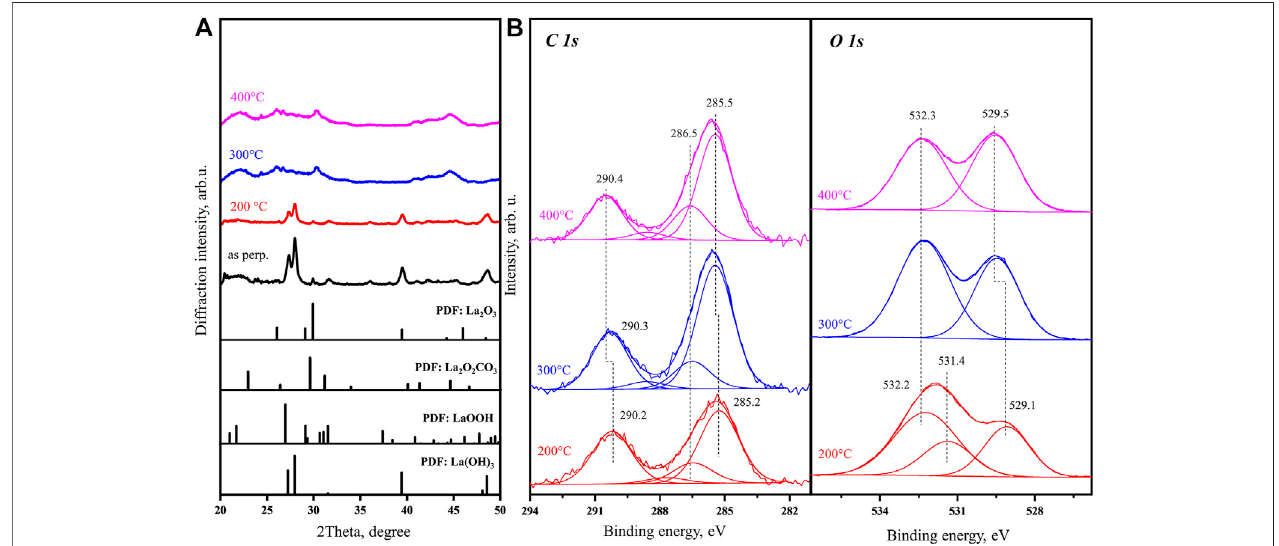
FIGURE 3 | (A) In situ XRD patterns obtained for as-prepared fresh La 2 O 3 sample at room temperature, 200, 300, and 400 ° C with PDF database of La(OH) 3 , La 2 O 2 CO 3 ,LaOOH,andLa 2 O 3 asreference. (B) Insitu C1sandO1scorelevelXPSspectraobtainedforanas-preparedfreshnanorodLa 2 O 3 sampleheldat200,300, and 400 °